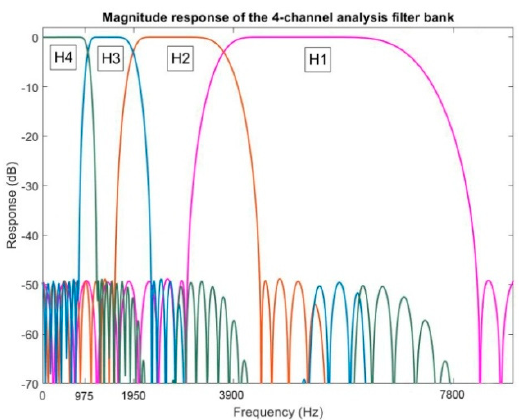
Figure 4. The frequency response for the analysis filter banks.